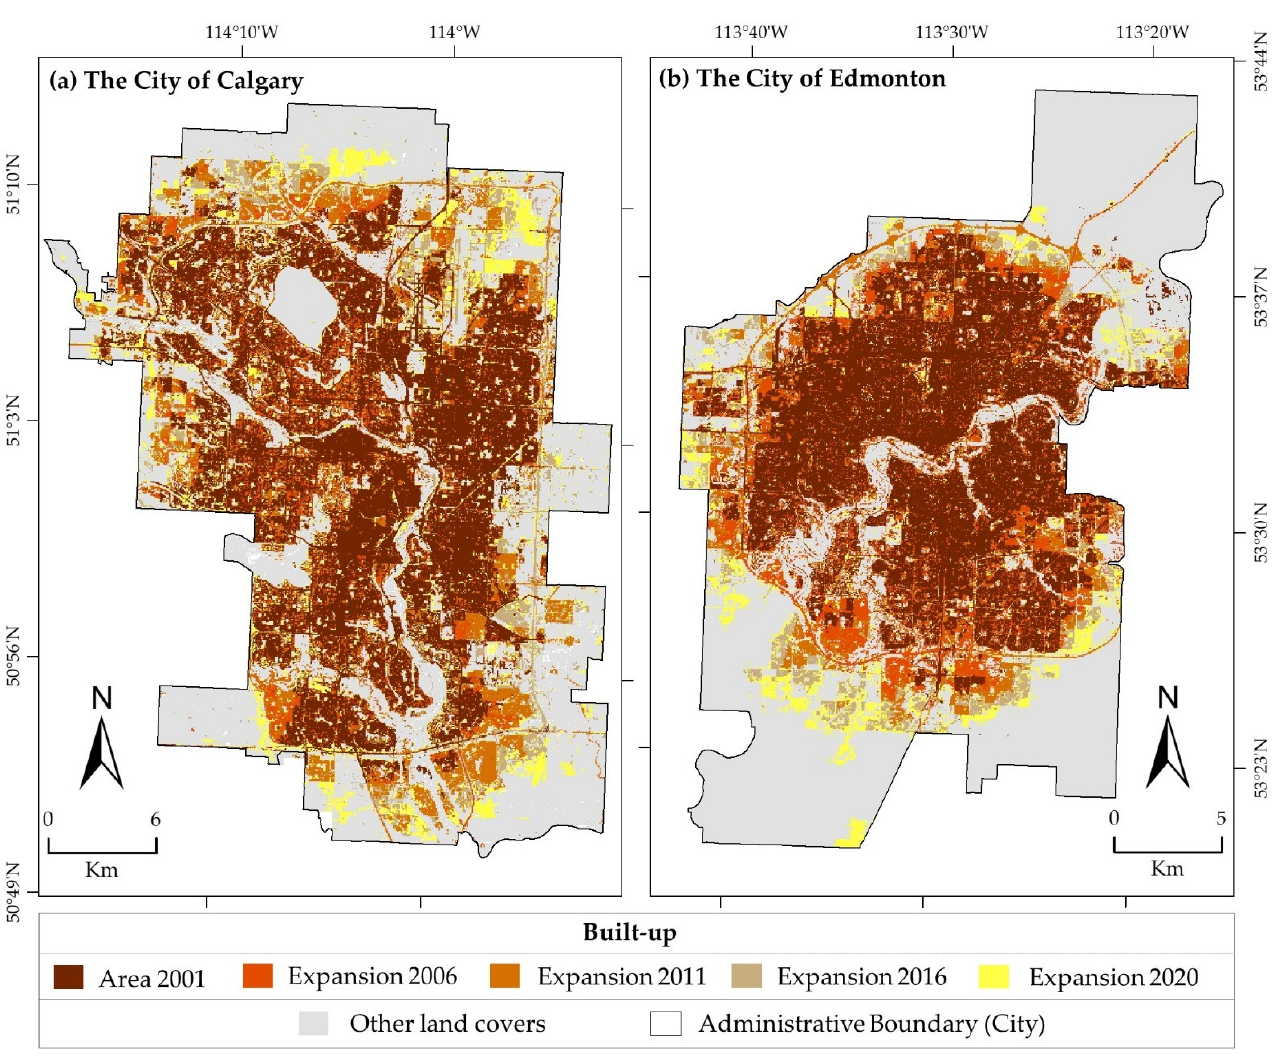
Figure 5. Built-up area changes in the city of Calgary ( a ) and city of Edmonton ( b ) from 2001 to 2020.